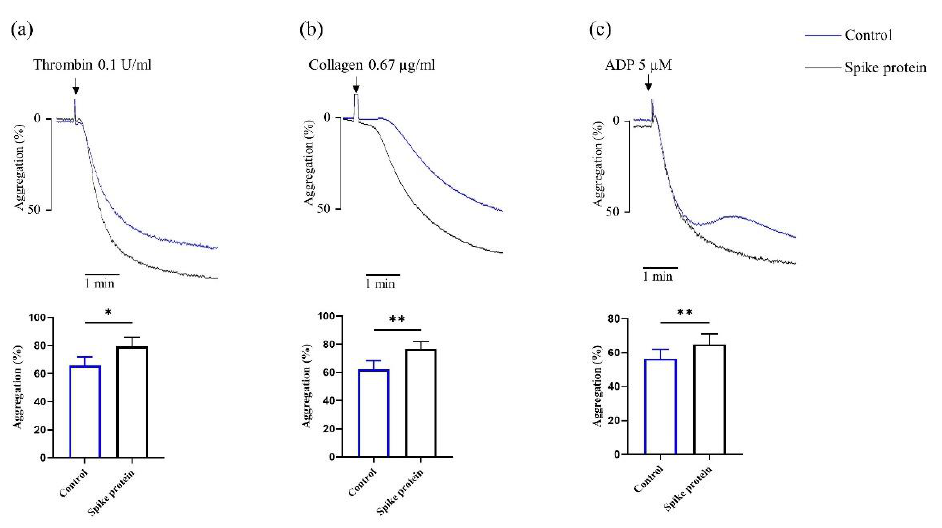
Figure 1. Spike protein potentiates platelet aggregation. Platelets were incubated with 2 μg /mL spike protein for 10 min, then gel-filtered platelets activated with ( a ) 0.1 U/mL thrombin ( n = 4), ( b ) 0.67 μg /mL collagen ( n = 4), and ( c ) PRP stimulated with 5 μM ADP ( n = 6), the platelet aggregation was monitored for 5 min. All data are presented as mean ± SEM. * p < 0.05, ** p < 0.01 indicate a significant difference compared to the control group.